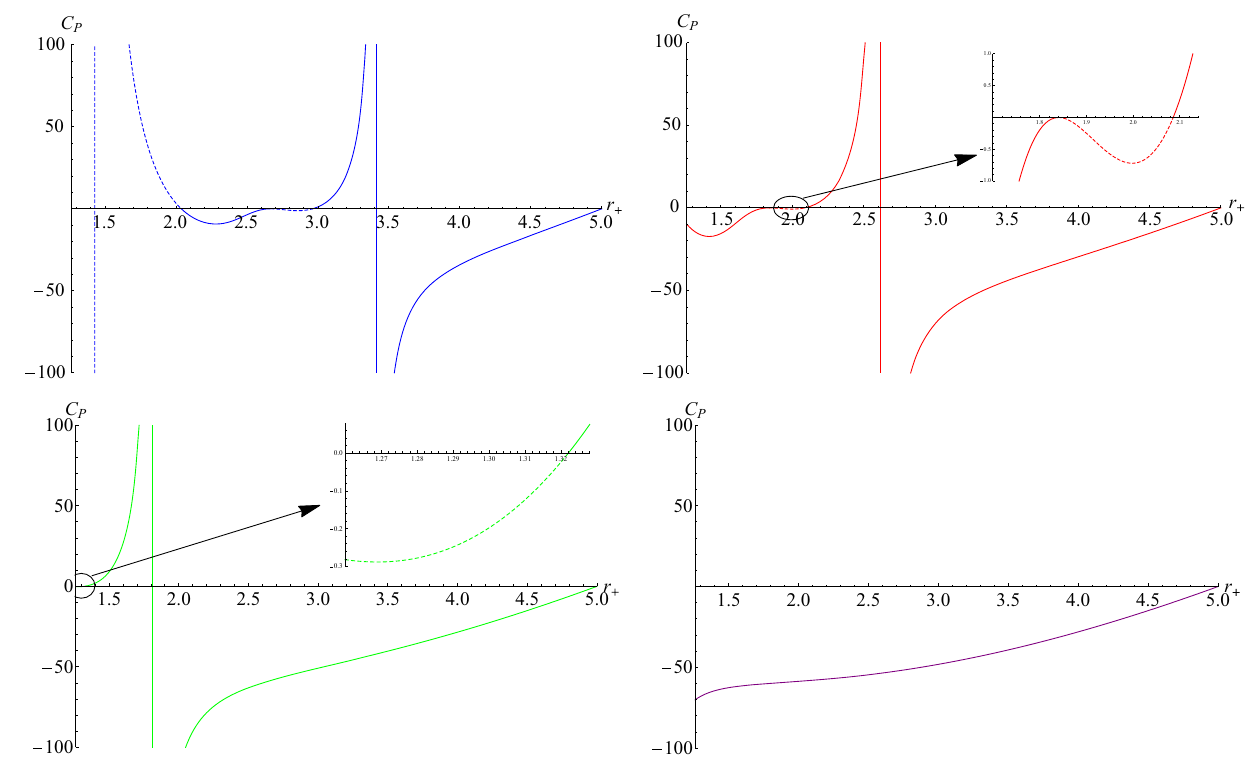
Fig. 11 Plotsoftheeffectiveheatcapacityintermsoftheeventhorizon radius r + under the different values of the magnetic charge, at r c = 5. They correspond to Q = 2 (top left), Q = 1 . 5 (top right), Q = 1